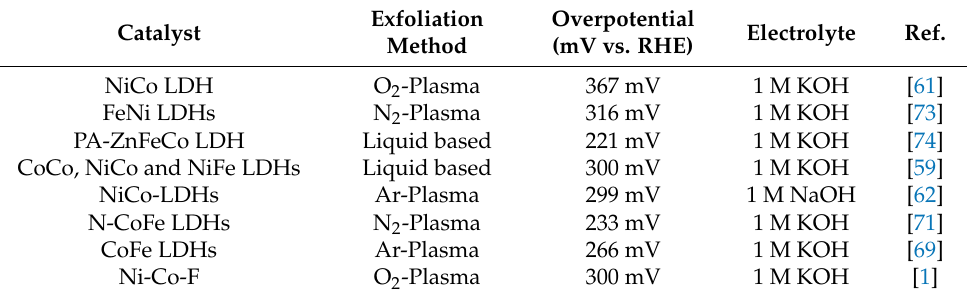
Table 1. Comparison of OER activities of exfoliated TM-LDHs ( η is at 10 mA cm − 2 ). Catalyst